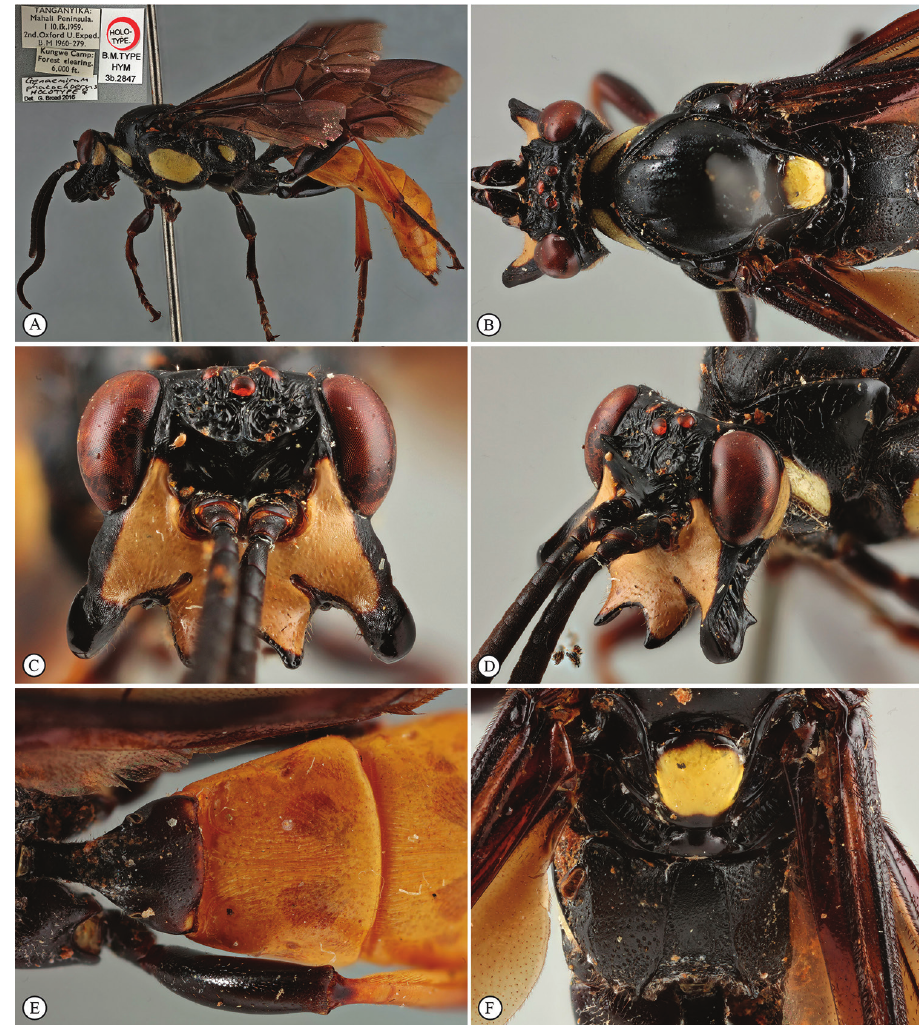
Figure 3. Genaemirum phacochoerus sp. n. Holotype female. A habitus lateral view (inset: data labels) B head, mesosoma, dorsal view C head anterior view D head, mesosoma anterior-lateral view E metasomal tergites 1-4 dorsal view F propodeum, dorsal